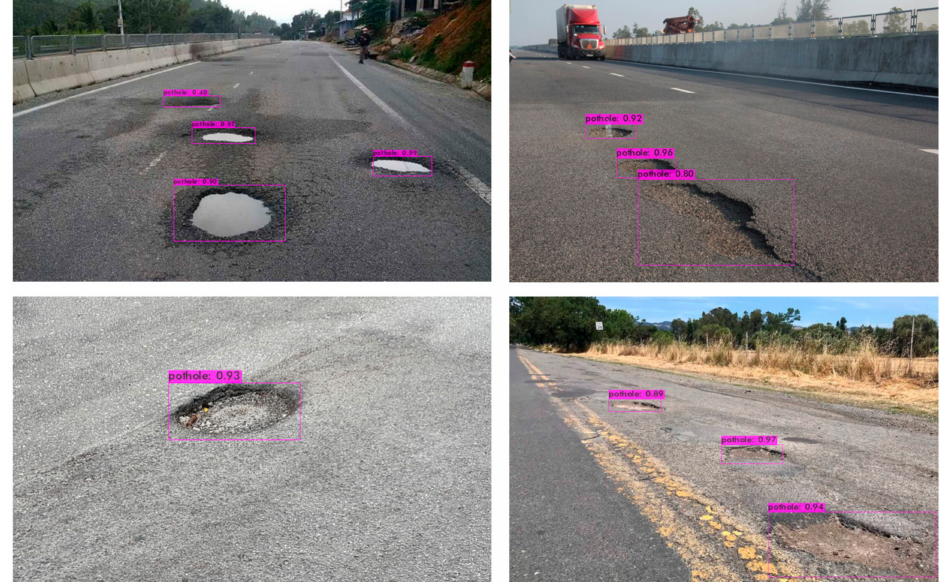
Figure 8. Detection outputs obtained by YOLOv4 model.